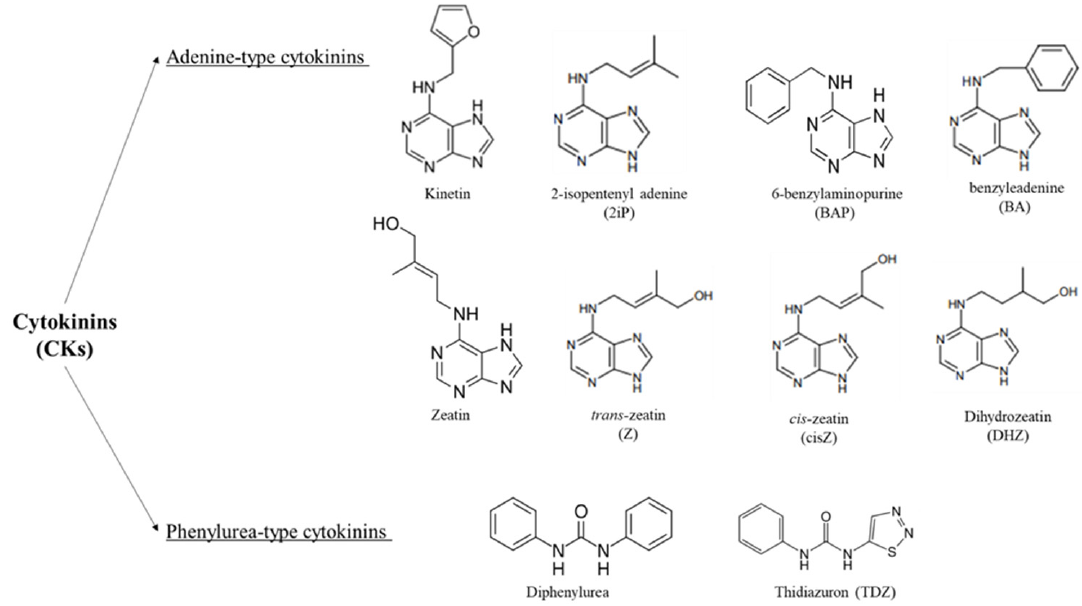
Figure 1. Chemical structures of cytokinins (CKs); adenine-type and phenylurea-type cytokinins are shown.